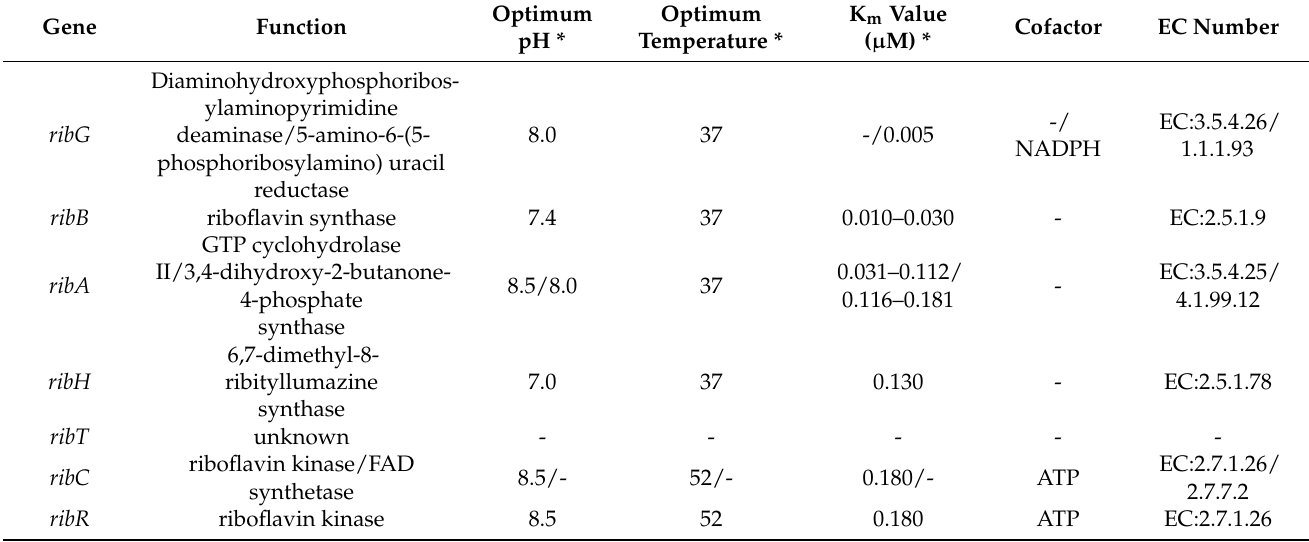
Table 1. Riboflavin biosynthetic and regulatory genes in B. subtilis